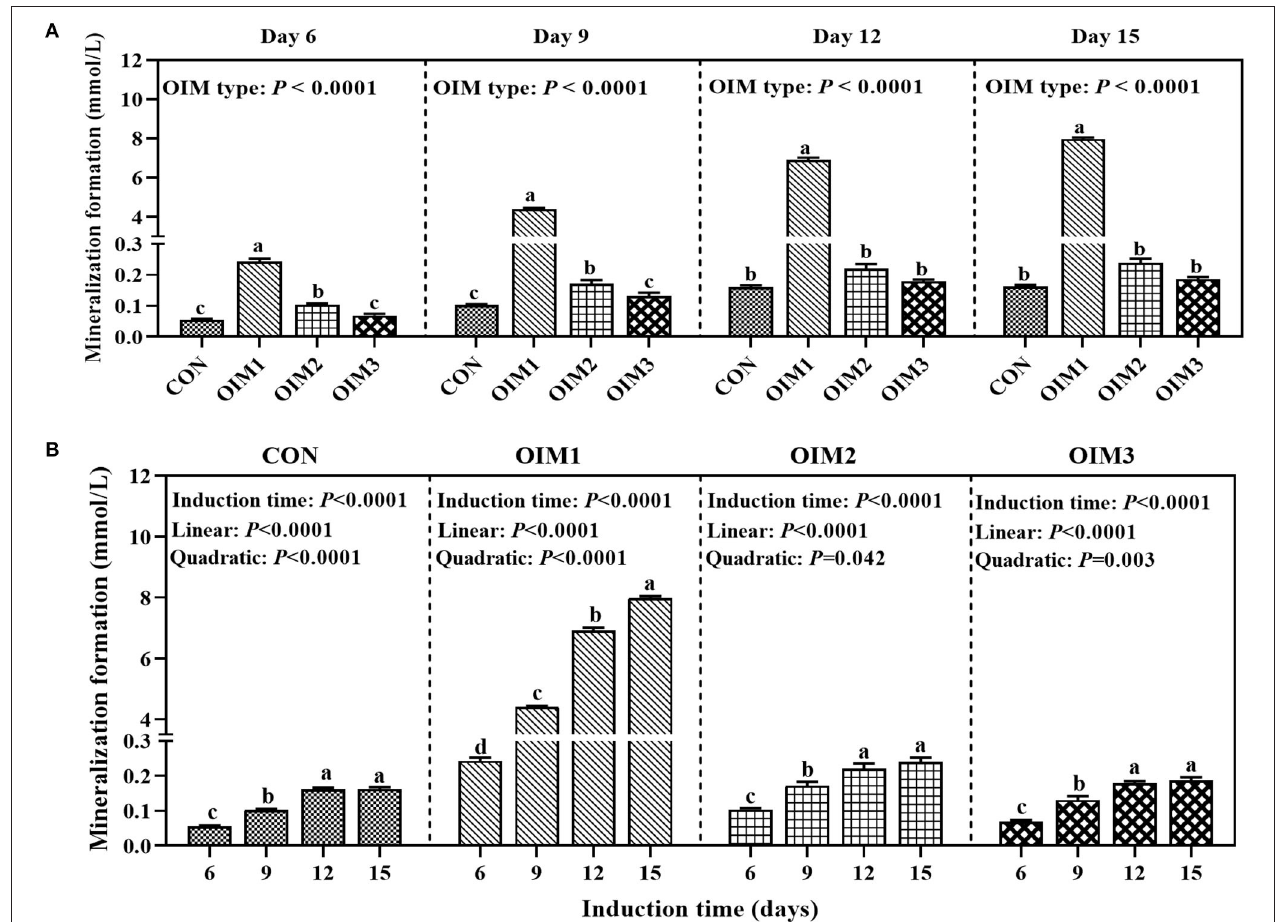
FIGURE 1 | Effect of OIM type (A) or induction time (B) on mineralization formation in primary cultured tibial osteoblasts of broiler chicks (experiment 1). All values are expressed as means ± SE, n = 6. Means without a common letter differ, P < 0.05. CON, complete culture medium; OIM1, complete culture medium supplemented with 100nM Dex, 50ug/mL Asc, and 10 mmol/L β -Gly; OIM2, complete culture medium supplemented with 100nM Dex and 50ug/mL Asc; OIM3, OIM2 supplemented with 10 mmol/L NaAlO 2 .